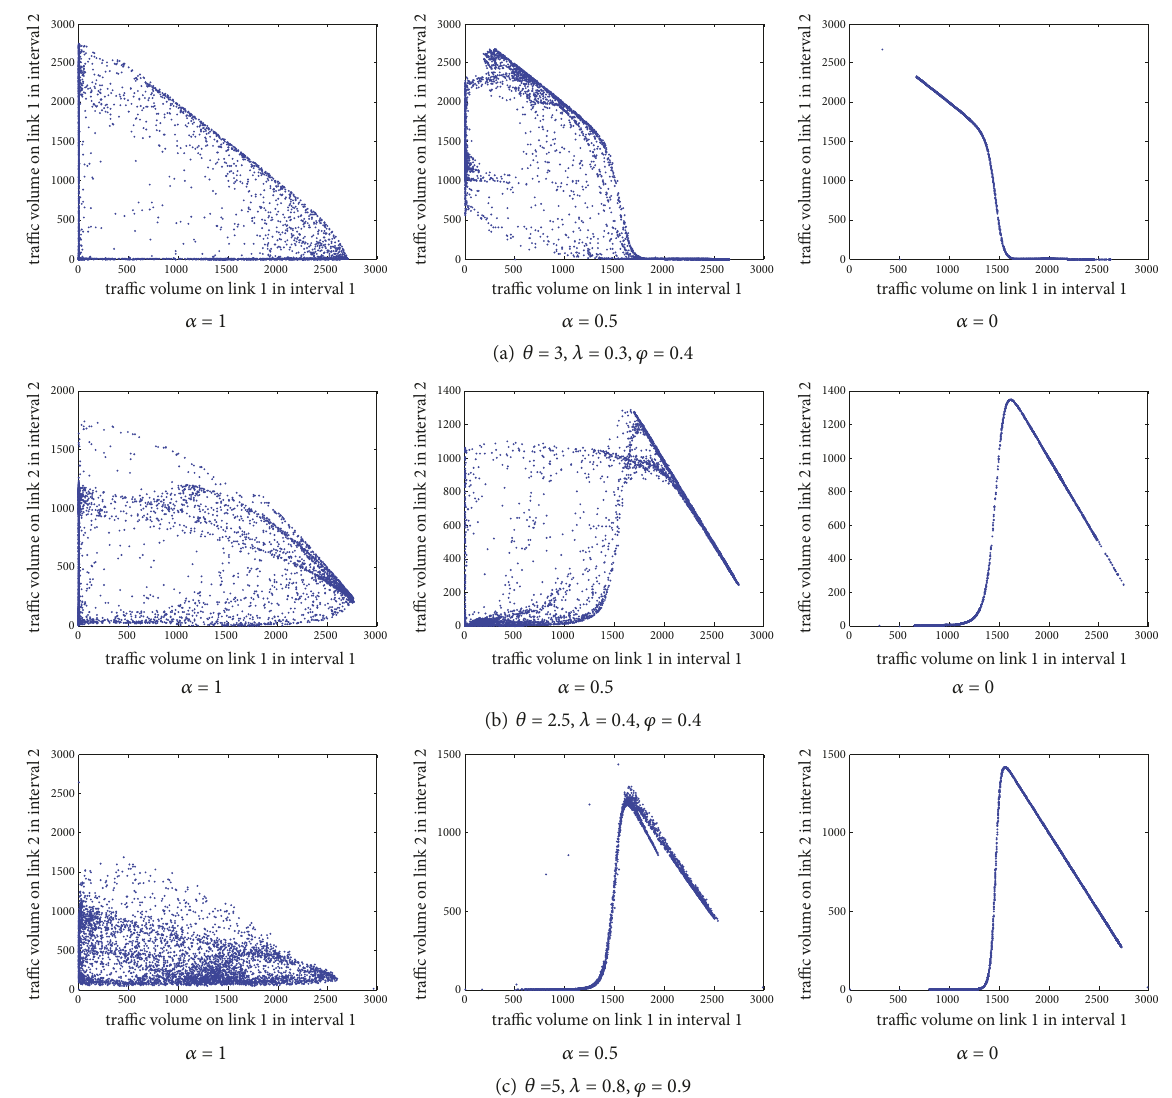
(c) 𝜃 =5, 𝜆 = 0.8, 𝜑 = 0.9 Figure 8: Projection of chaotic attractor for 𝛼 for specific 𝜃 , 𝜆 and 𝜑